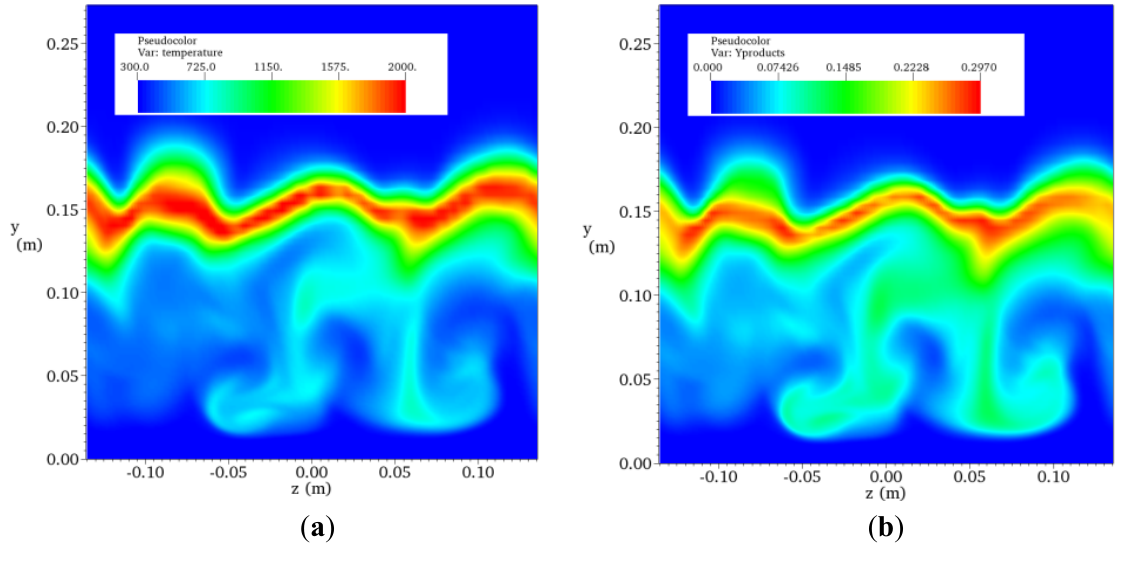
Figure 17. Temperature contours, contours of mass fraction of products ( Y projected velocity vectors on the cross section at 0.9 x = m. ( a ) Temperature; ( b ) Mass fraction of products; ( c ) Projected velocity